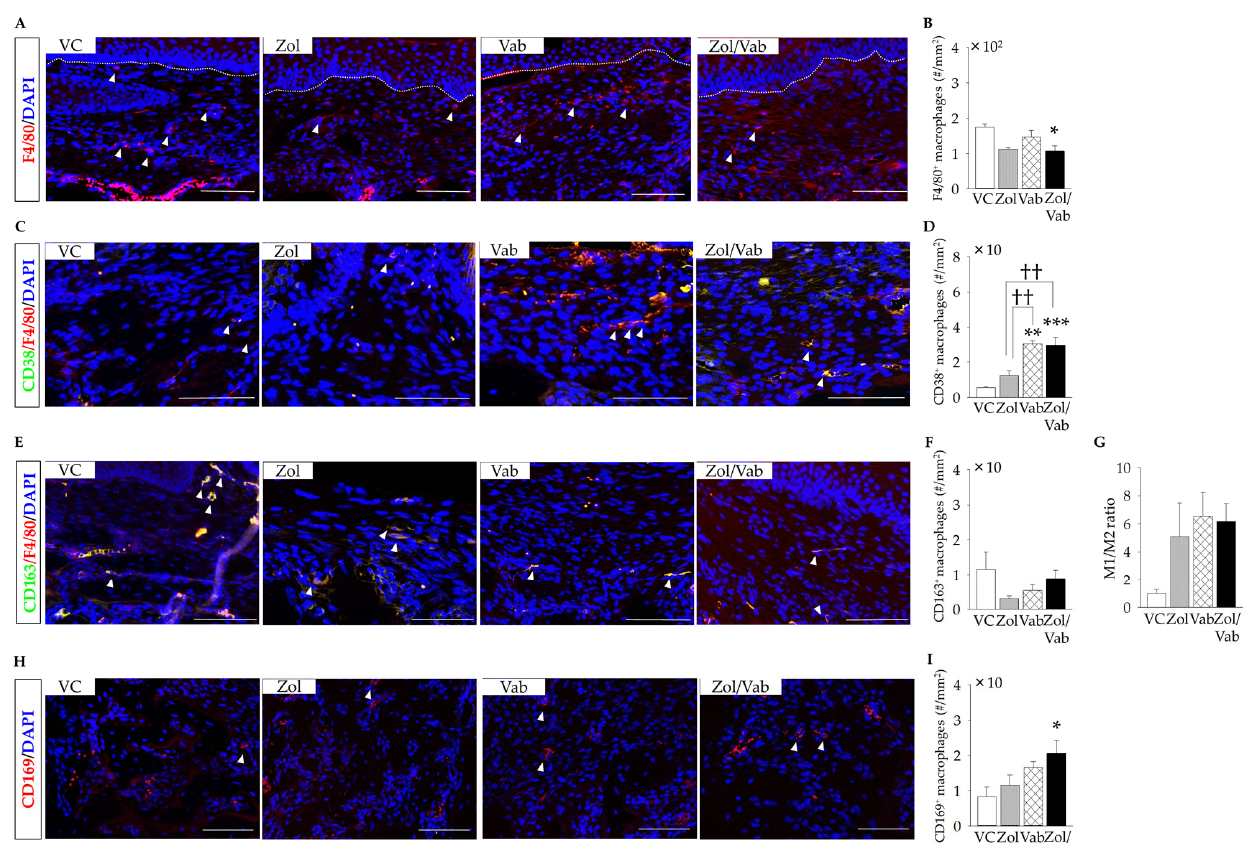
Figure 6. Effects of administered drugs on macrophages in the tooth extraction sockets. ( A ) Repre- sentative fluorescent image of F4/80 + macrophages (white arrowheads: F4/80 + macrophages, bar: 100 μ m). ( B ) The number of F4/80 + macrophages is significantly decreased in Zol/Vab vs. other comparison groups. ( C ) Representative fluorescent images of CD38 + macrophages (white arrow- heads: CD38 + macrophages, bar: 100 µ m). ( D ) The number of CD38 + macrophages is significantly increased in Zol/Vab vs. other comparison groups. ( E ) Representative fluorescent images of CD163 + macrophages (white arrowheads: CD163 + macrophages, bar: 100 µ m). ( F ) The number of CD163 + macrophages is similar among the comparison groups. ( G ) The M1/M2 ratio is slightly higher in Vab and Zol/Vab vs. VC. ( H ) Representative fluorescent images of CD169 + macrophages (osteomacs) (white arrowheads: CD169 + macrophages, bar: 100 µ m). ( I ) The number of CD169 + macrophages is greater in Zol/Vab vs. other comparison groups. Graphs show means ± SEM. * p < 0.05, ** p < 0.01, *** p < 0.001, †† p < 0.01; n = 5